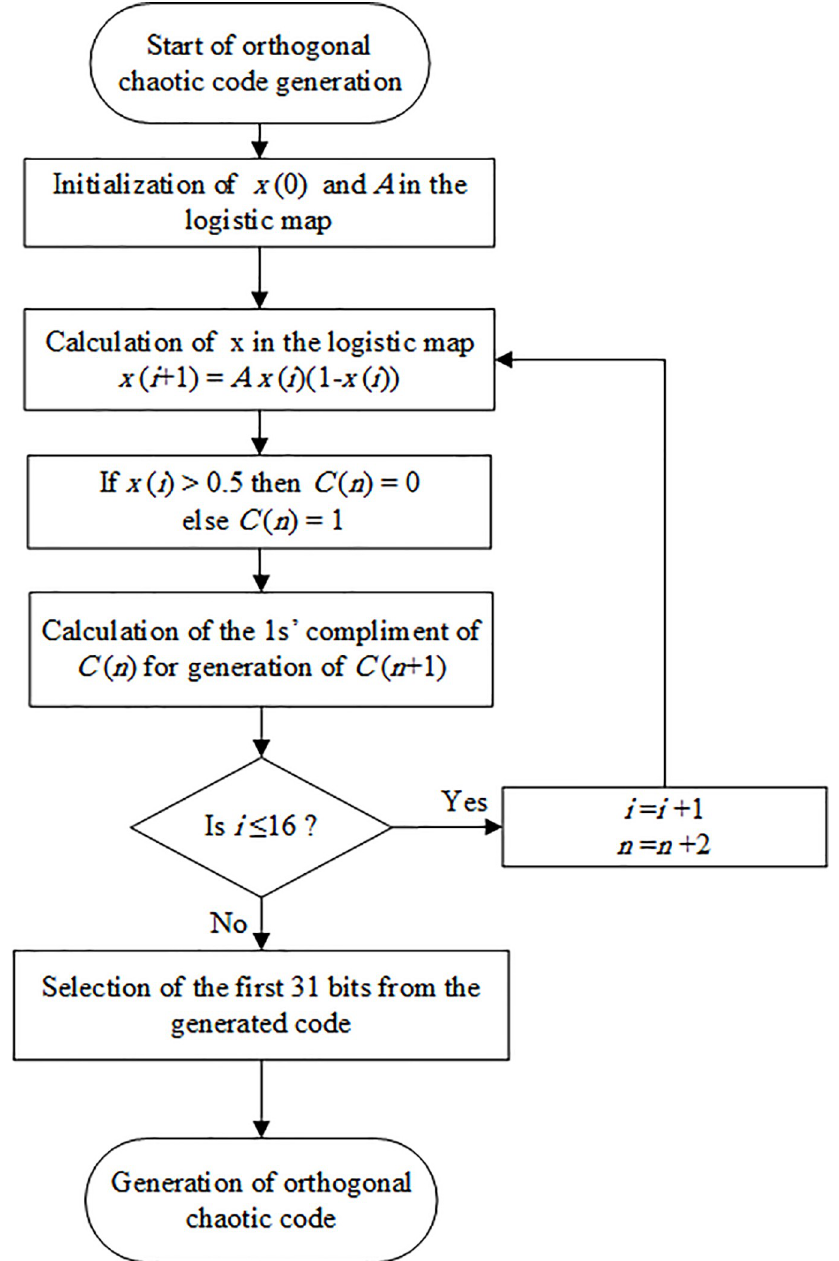
Fig 2. Flowchart for the generation of orthogonal chaotic